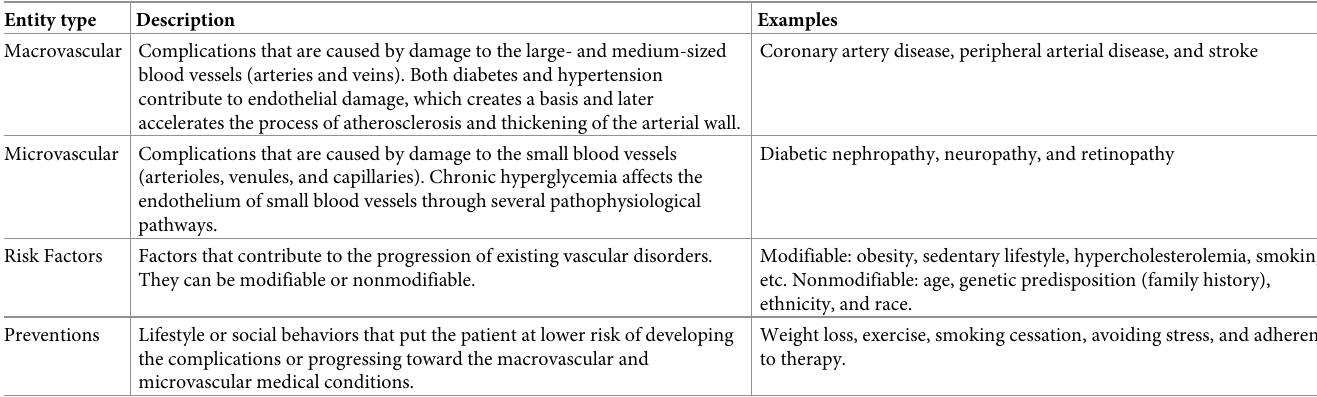
Table 2. Annotated entity classes in the PrevComp